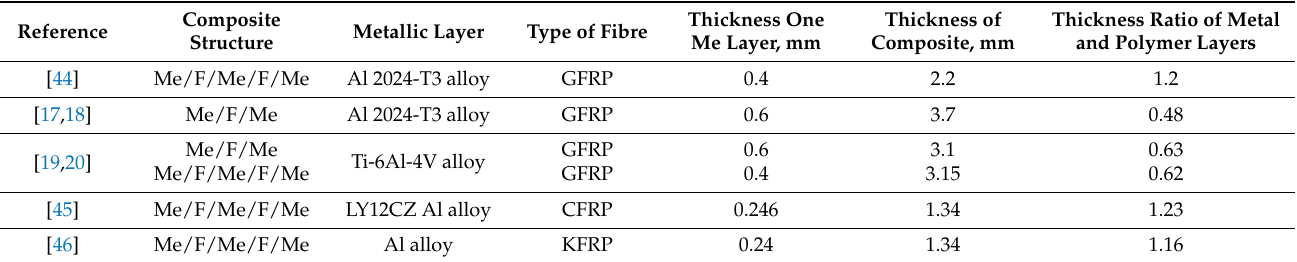
Table 1. Review of the layered materials utilised for numerical modelling using the relaxation model of plasticity for layered